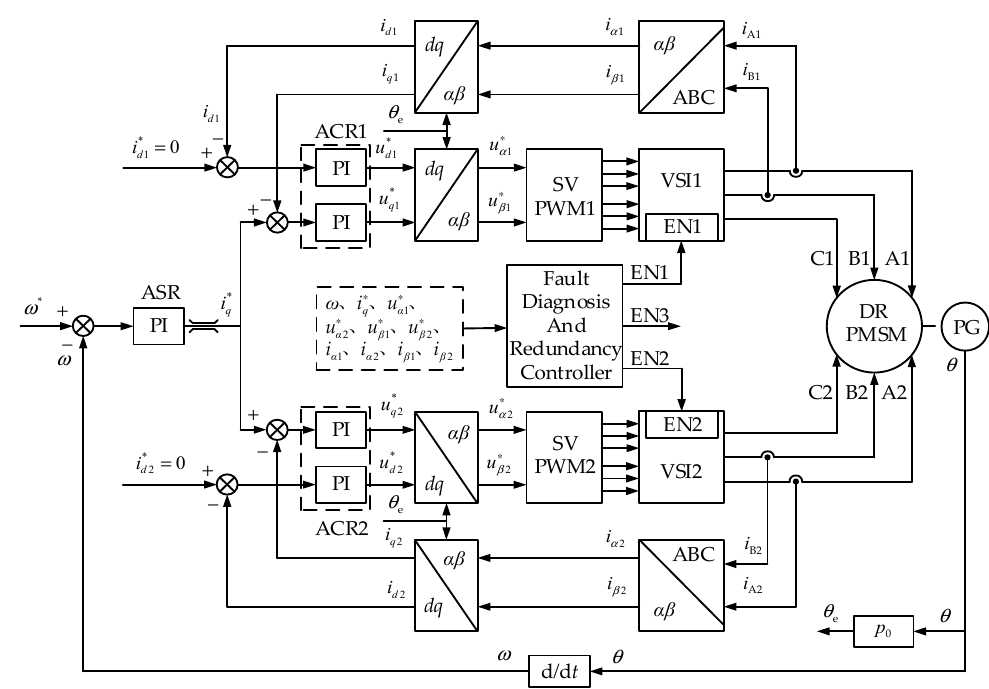
Figure 11. The simulation system block diagram of the DRPMSM.